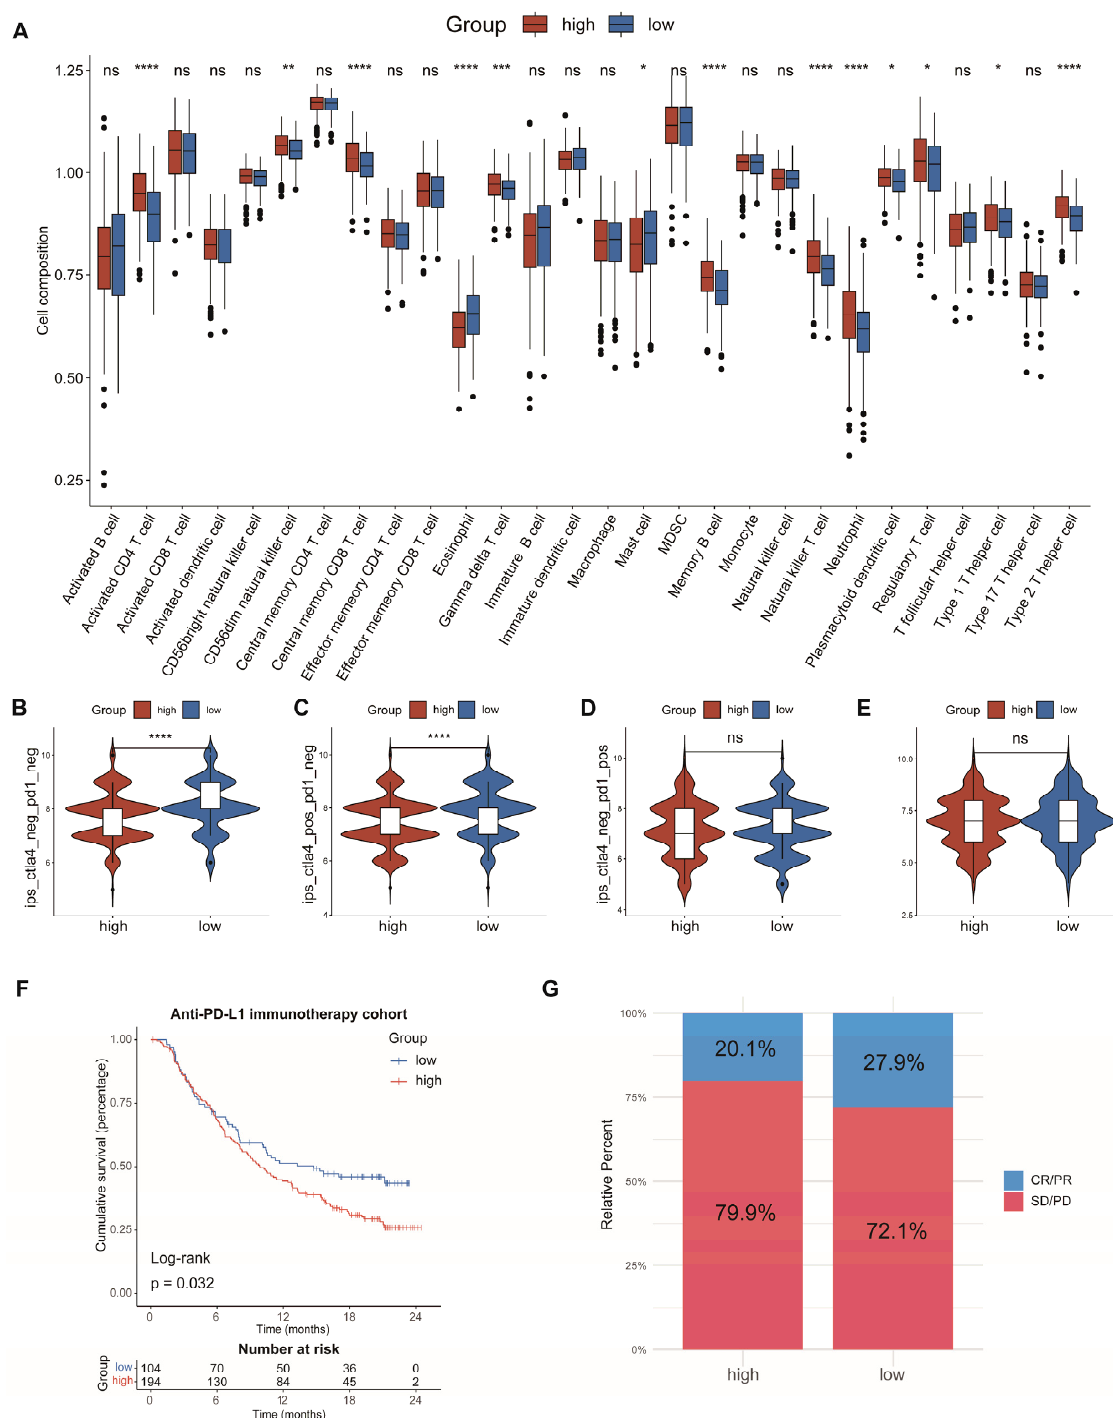
Figure 7. Analysis of immune cell infiltration and prediction of immunotherapy response. ( A ) The differences in the proportions of 28 immune cells between the two subgroups. ( B ) CTLA4 negative /PD-1 negative . ( C ) CTLA4 positive /PD-1 negative . ( D ) CTLA4 negative /PD-1 positive . ( E ) CTLA4 positive /PD-1 positive . ( F ) KM survival analysis in the anti-PD-L1 immunotherapy cohort. ( G ) Evaluation of response to anti-PD-L1 immunotherapy. CR, Complete Response; PR, Partial Response; SD, Stable Disease; and PD, Progressive Disease. P values were shown as ns: p > 0.05; * p < 0.05; ** p < 0.01; *** p < 0.001; **** p < 0.0001.